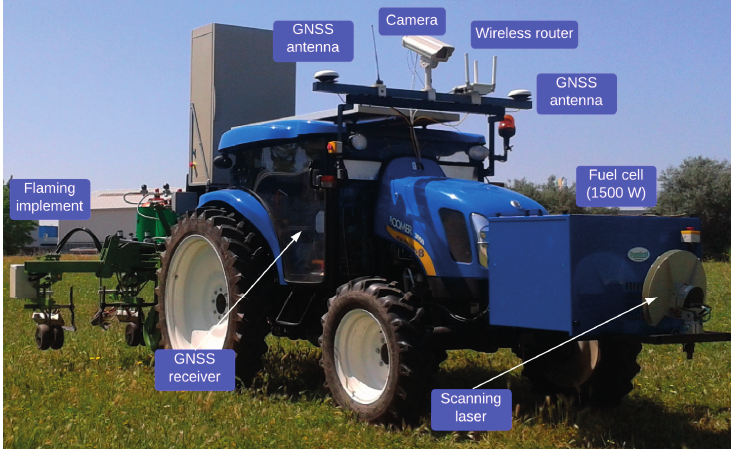
Figure 1. Intelligent off-road vehicle unit